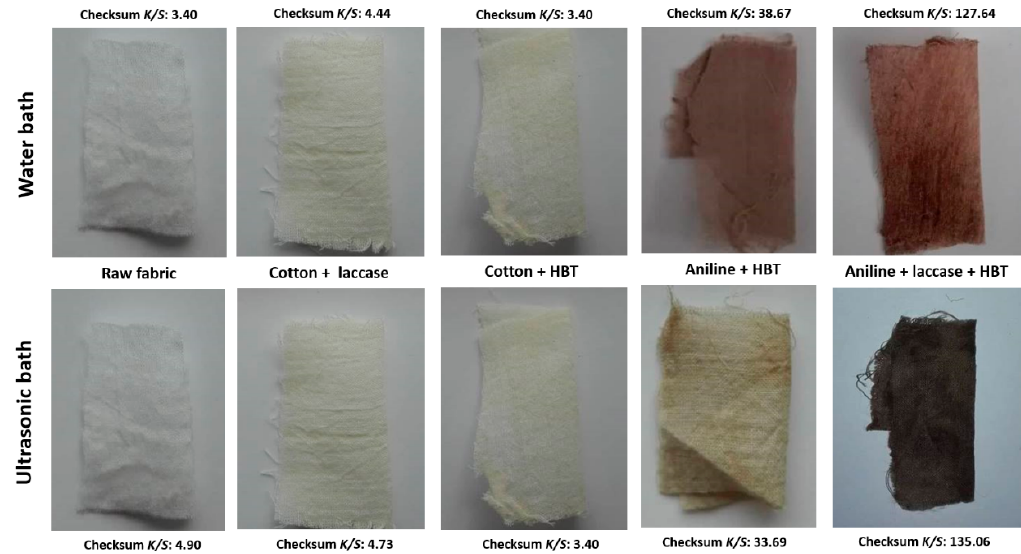
Figure 4. Photographs and spectral values of samples coated using different reactors, water bath and ultrasonic bath, under different conditions: raw fabric; cotton + laccase; cotton + HBT; cotton+ laccase + no HBT; cotton + laccase + HBT.